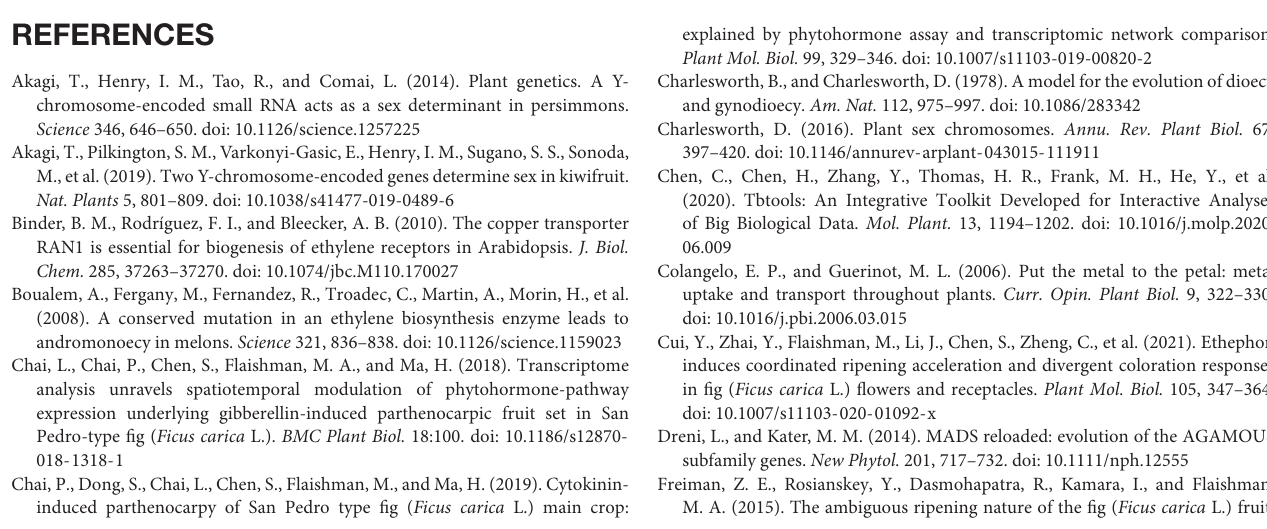
Supplementary Figure 3 | AG-Marker validation results for two F1 populations. “M” marks male individuals and “F” marks female individuals. Supplementary Figure 4 | Alignment of RAN1 amino acid sequences from different species. Blue box indicates SNP site. Supplementary Table 1 | List of fig cultivars and sex-identification results. Sheet 1 includes all fig cultivars and populations tested in this study. Light green marks female and light orange marks male. Sheet 2 presents the statistical data pertaining to the results. Supplementary Table 2 | Coding sequences (CDS) and protein sequences used in this study. Supplementary Table 3 | AG-related sequences screened from “Purple Peel” fig transcriptome and “Dottato” fig protein files. Red bold, the only AG gene screened. Supplementary Table 4 | Protein-coding gene sequences extracted from the “Dottato”